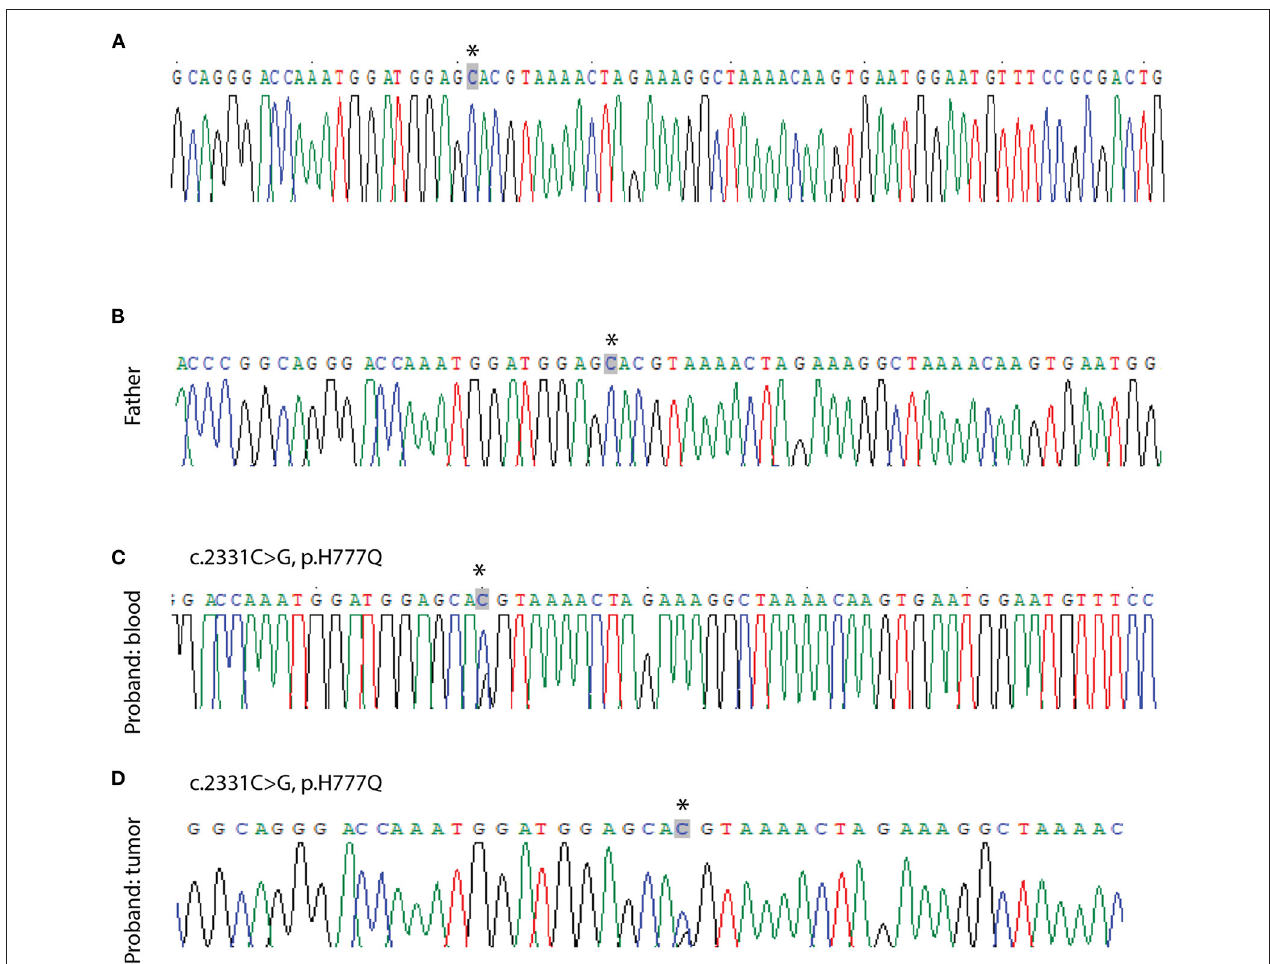
FIGURE 4 | Sanger sequencing validation of point mutations in GLI3 . No mutation is seen in the peripheral blood lymphocyte sample from the patient’s mother (A) and father (B) . A c.2331C > G mutation is seen in the patient’s blood sample (C) and tumor sample (D) . Arrows indicate the ivariant.